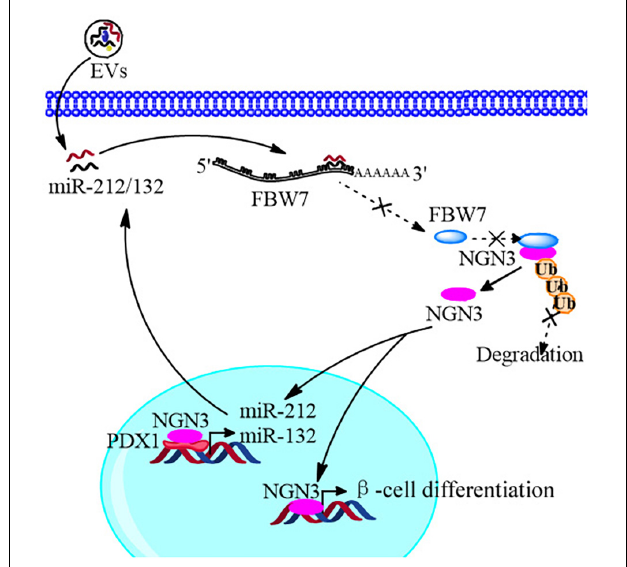
FIGURE 10 | Schematic diagram of the EVs promoting β -cell differentiation from human pluripotent stem cells.